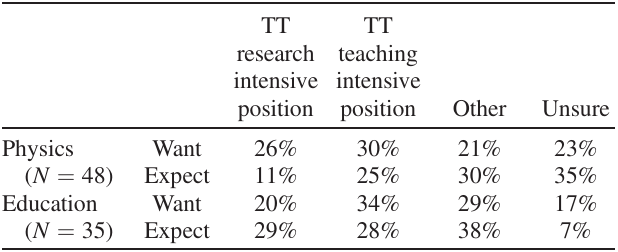
TABLE III. Where PER graduate students want to work and expect they will be working in ten years (values are the percentage of the subgroup populations).